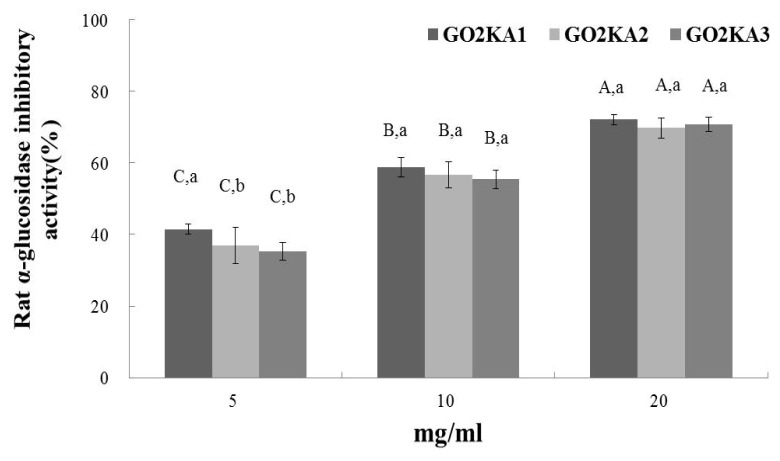
Dose dependent changes in rat intestinal α-glucosidase inhibitory activity (% inhibition) of chitosan oligosaccharides classified by molecular weight (GO2KA1; MW < 1000 Da, GO2KA2; MW 1000–10,000 Da, GO2KA3; MW > 10,000 Da). The results represent the mean ± S.D. of values obtained from three measurements. Different corresponding letters indicate significant differences at p < 0.05 by Duncan’s test. A−C First letter is among different samples and a−c second one is among different concentrations within same samples.